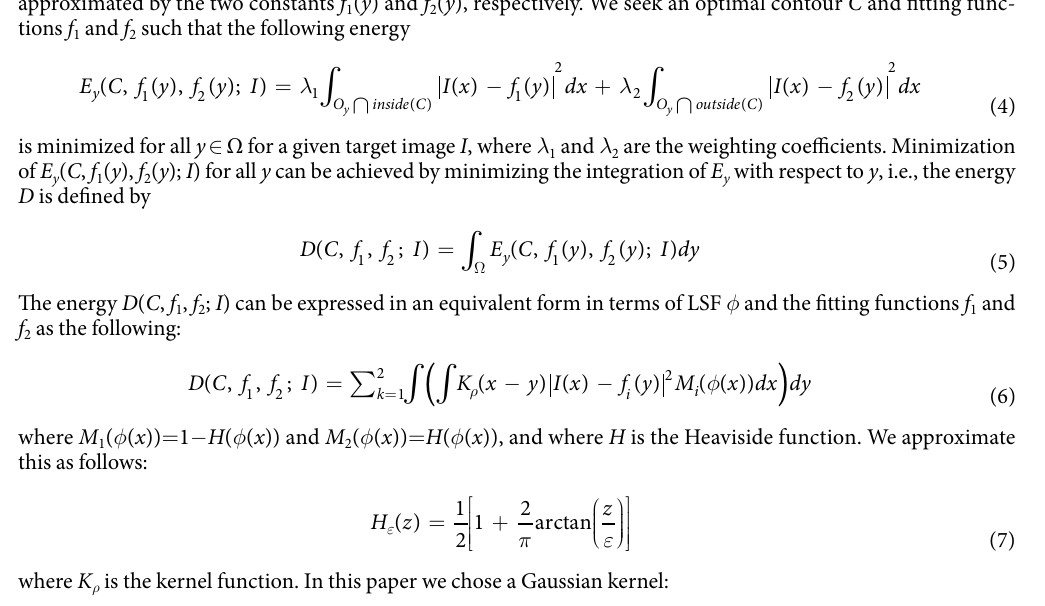
2 iN ∫ ∑ φ φ φ ω φ φ ... = i i 1 1 (2) N N where ω i ( x ) is a local weight assigned to the i -th label represented by the level set function φ i , with ω ∑ = = x ( ) 1 , i 1 i x indexes the image pixels, and Ω denotes the target image domain. Both ANTS and DRAMMS calculate the local similarity of each voxel in the registration procedure, where we use the local similarity as the local weight of the level set function. This strategy does not add computational burden to the algorithm, since the atlases are regis- tered to the target image offline. Minimizing label fusion energy F , the zero LSF φ is forced to be close to the zero LSF φ 1 , … , φ N , which are the . However, minimizing the energy F alone boundaries of the thalamus given by the warped labels ′ ′ ... ′ L L L , , , N 1 2 may result in an irregular shape of the contour obtained. Therefore, we need a regularization mechanism to main- tain the regularity of the contour. We use the arc length of the zero level contour of the LSF φ as the regularization. ∫ φ φ = ∇ R This regularization term ensures the regularity of the boundary of the thalamus. The traditional fusion method only combines the warped labels, without taking into account the target image information. These methods cannot correct the registration error and manually delineated errors effectively. We use the region-scalable fitting (RSF) model 24 as the image term, which is able to handle intensity variations within the foreground and background of the image due to its localization property. This image term can guide the motion of the contour toward the thalamus boundaries, if there are some registration errors and manual labelling errors. Given a point y , consider it’s neighborhood O y = { x :| x − y | ≤ ρ }, which is divided by an object boundary C into